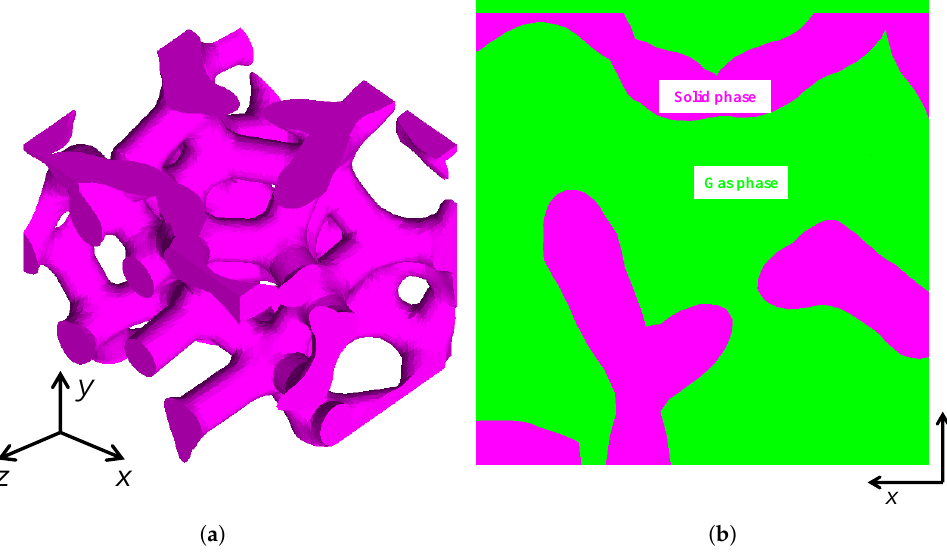
Figure 2. Illustration of ( a ) a porous structure and ( b ) a RVE composed of the solid and gas phases. (The reader is referred to the web version of this paper for interpretation of the references to color in this